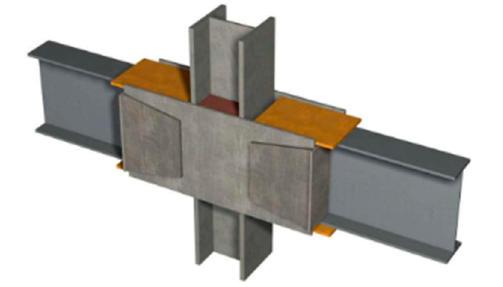
Figure 6. Strengthening connection by side plates [8].